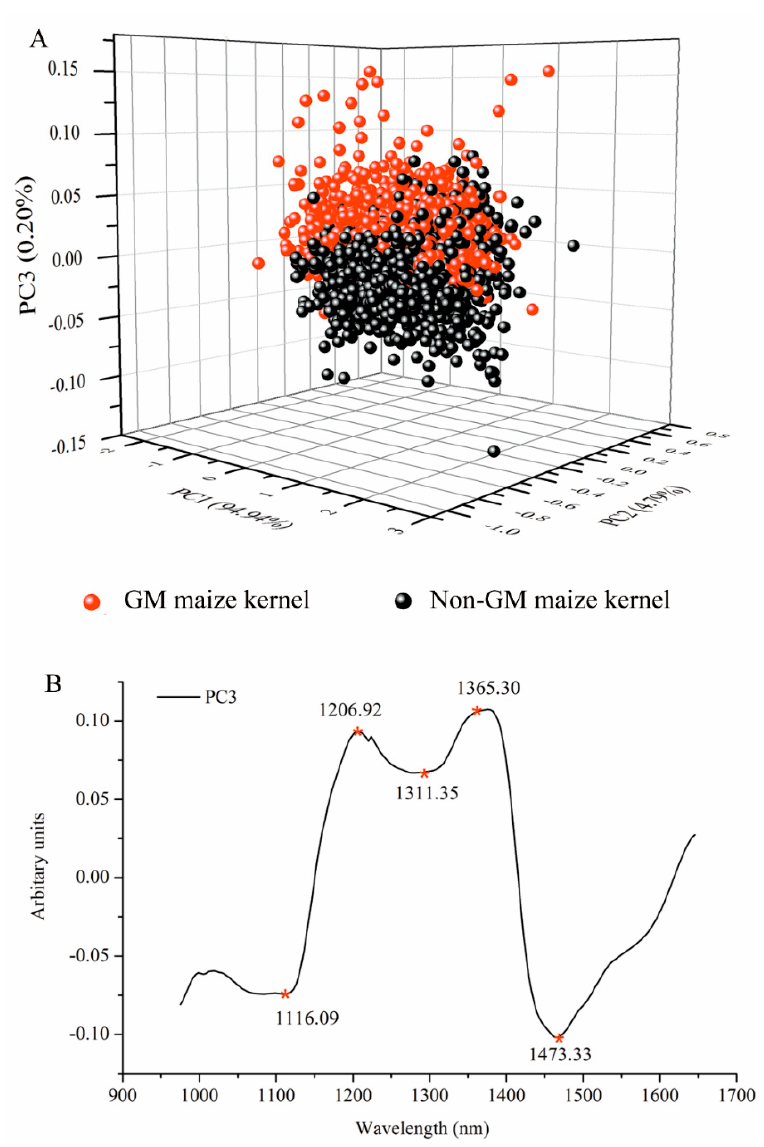
Figure 4. Three-dimensional principal component analysis (PCA) scores scatter plot of the first three principle components (PCs) for the GM and non-GM maize kernels with raw spectra ( A ) after pre-processing and ( B ) main peaks of PC3 loadings that are indicative of the differences between GM and non-GM maize kernels.